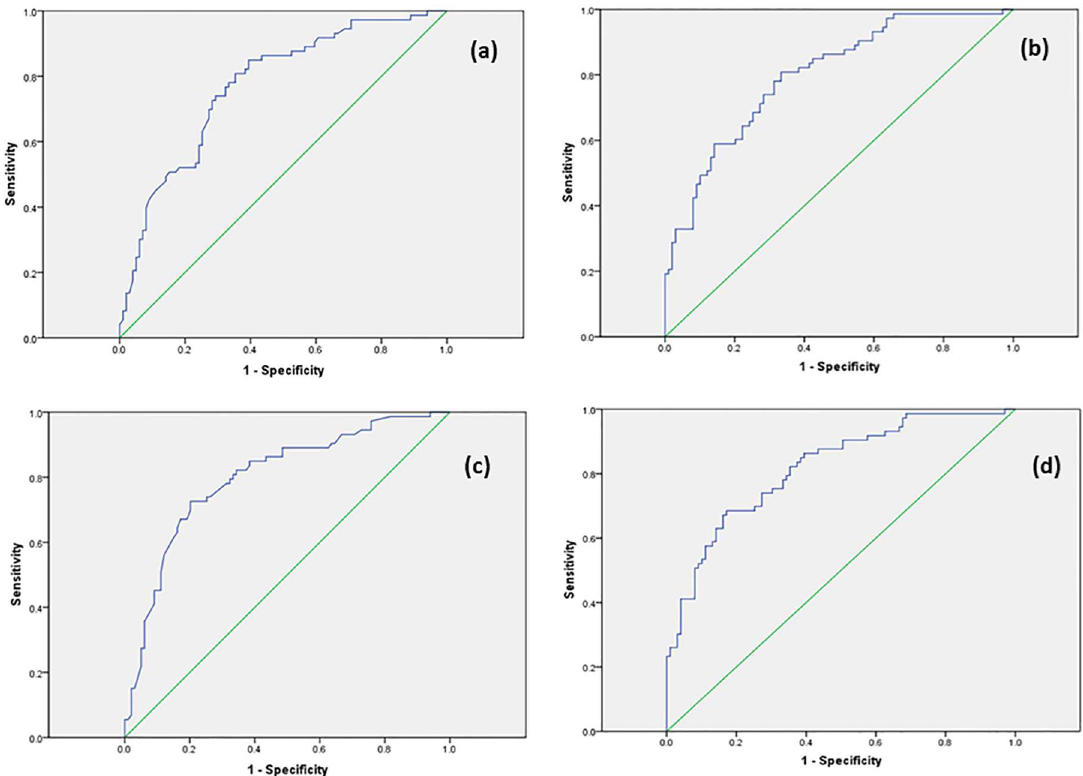
Fig 2. A receiveroperating characteristic (ROC) curve generated by the MS risk score when the score of people with MS is compared to that of healthy controls. (a) IncludingHLA-DRB1 * 1501only. (b) Includingfull genetic information. (c) Includinggenetic informationfrom HLA-DRB1 * 1501only, and excludingserum 25-hydroxyvitamin D levels. (d) Includingfull genetic information, and excludingserum 25-hydroxyvitamin D